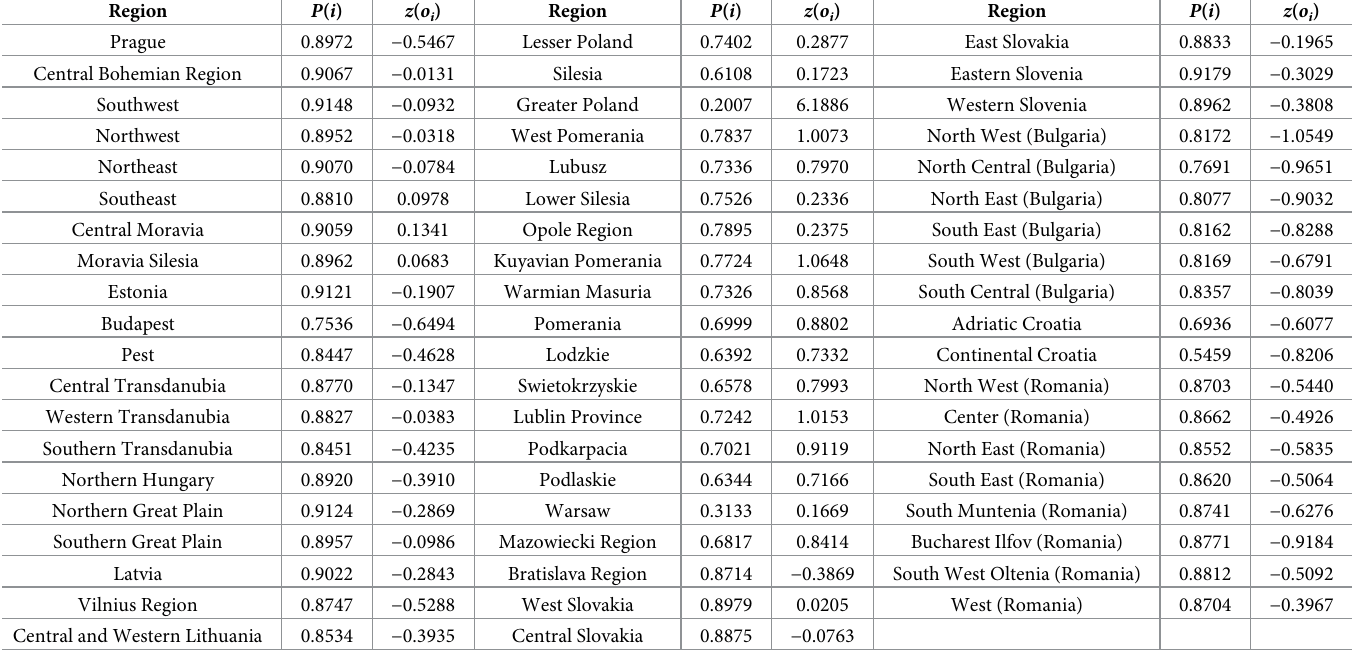
Table 8. Multiplex participation coefficient P ( i ) with Z -scores (CEE